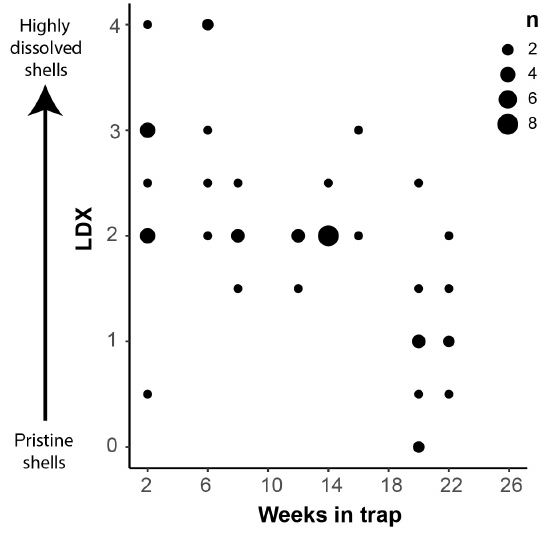
Figure 4. Shell condition of Heliconoides inflatus , ranked on the Limacina Dissolution Index (LDX) scale, plotted against the maxi- mum amount of time specimens spent in the sediment trap (i.e., the number of weeks from the trap opening time). The size of the sym- bols corresponds to n , the number of specimens plotted at a given point.